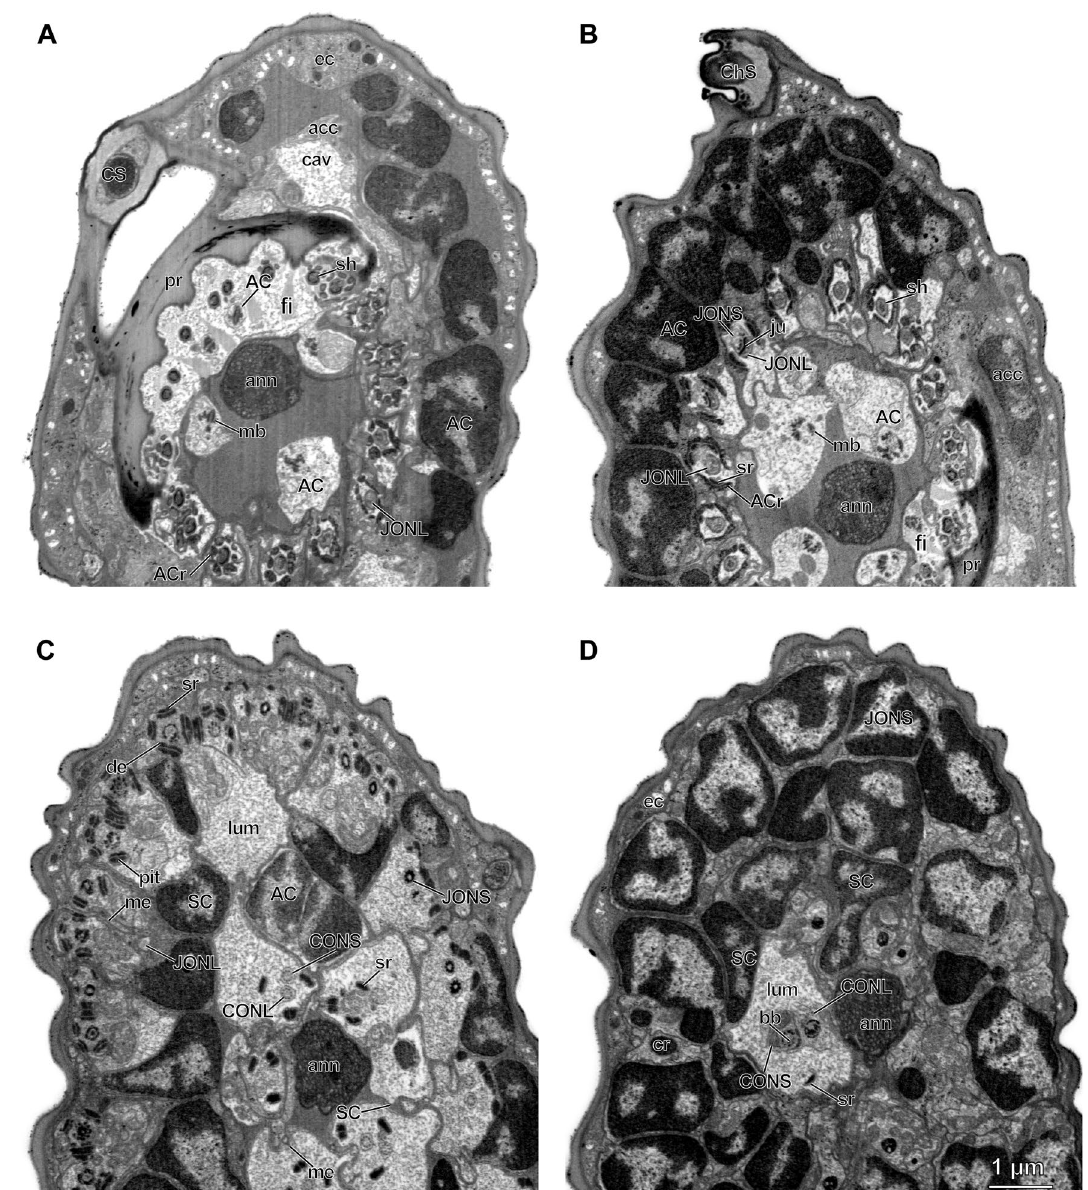
Figure 3. Cross sections of Megaphragma viggianii pedicellar chordotonal organs. ( A ) Section through the distal end of the pedicel. Antennal nerve is surrounded by five central organ (CO) attachment cells (AC) and tips of long Johnston’s organ neurons (JONL) cilia. Nuclei of Johnston’s organ (JO) AC occupy the outermost part of the pedicel, adjoining to the epidermal and accessory cells. A sensillum campaniformium (CS) is observed in the periphery. ( B ) Cross section at the 4/5 of the pedicel length. Cell bodies of JO AC are tightly packed, inside their rods lie the tips of scolopale rods. An intercellular junction between JO cilia is visible. The base of the sensillum chaeticum is observed in the periphery. ( C ) Cross section at the 2/3 of the pedicel length. Dendrites of short JO neurons (JONS) lie in the periphery; desmosomes connect them to the scolopale rods. Large lumina are formed by JO scolopale cells (SC), whose nuclei acquire twisted shapes to provide space for it. ( D ) Section through the middle of the pedicel. Neuron bodies surround CO scolopidia and antennal nerve, they are tightly packed. Elongated and twisted SC nuclei occupy the outermost sides of CO scolopidia. (acc— accessory cell, ACr—AC rods, an—annelus, ann—antennal nerve, ax—axoneme, bb—basal body,